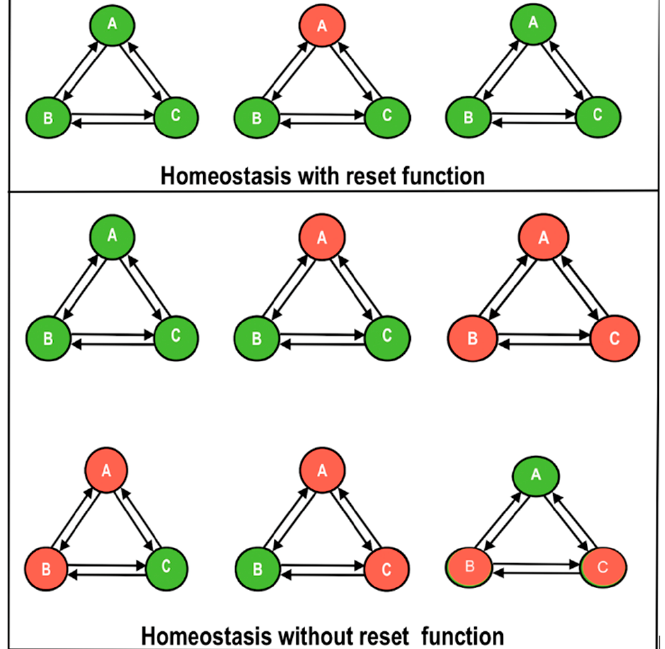
Figure 4. The dyshomeostasis hypothesis showing three processes or systems, A, B, and C. Upper panel: functioning normally, homeostasis resets any process that strays into disequilibrium. Upper left: A, B, and C are shown in equilibrium (green color). Upper center: A has fallen out of equilibrium (red) and requires a reset. Upper right: A is reset, and all three processes have returned to equilibrium. Lower panel: a non-resetting state of chronic dyshomeostasis is shown. Centre left: three systems A, B, and C in equilibrium (all green). Centre: A is out of equilibrium and requires a reset. Right: the system fails to reset and remains in disequilibrium. Lower left: A and B both are out of equilibrium. Lower center: A and C are out of equilibrium. Lower right: B and C are out of equilibrium. The system as a whole remains in unstable